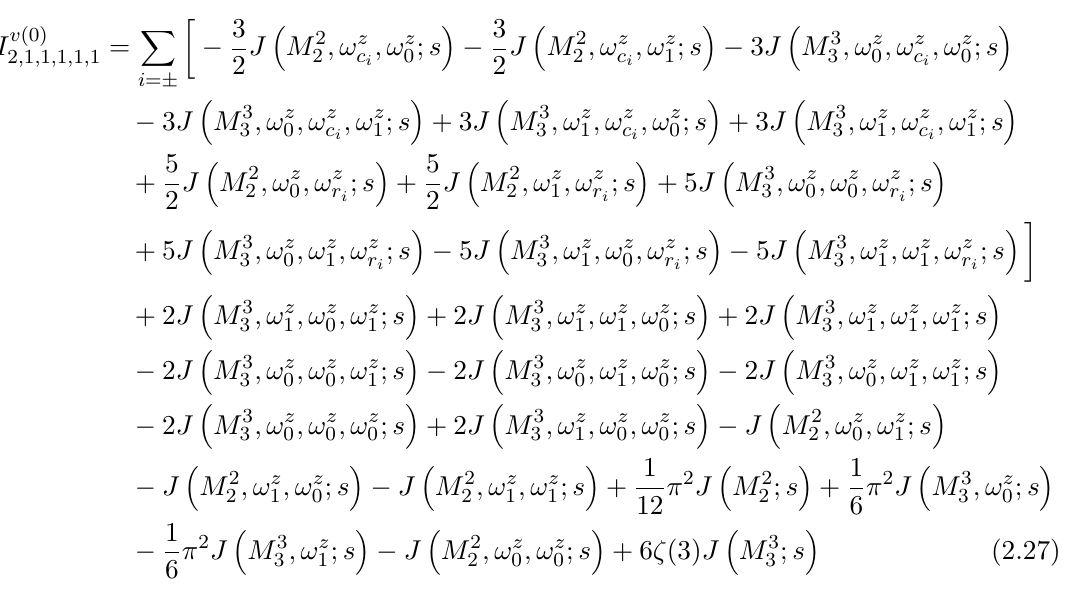
Figure 2 . Plot of the ε 0 correction to the I v numerically with the FIESTA package